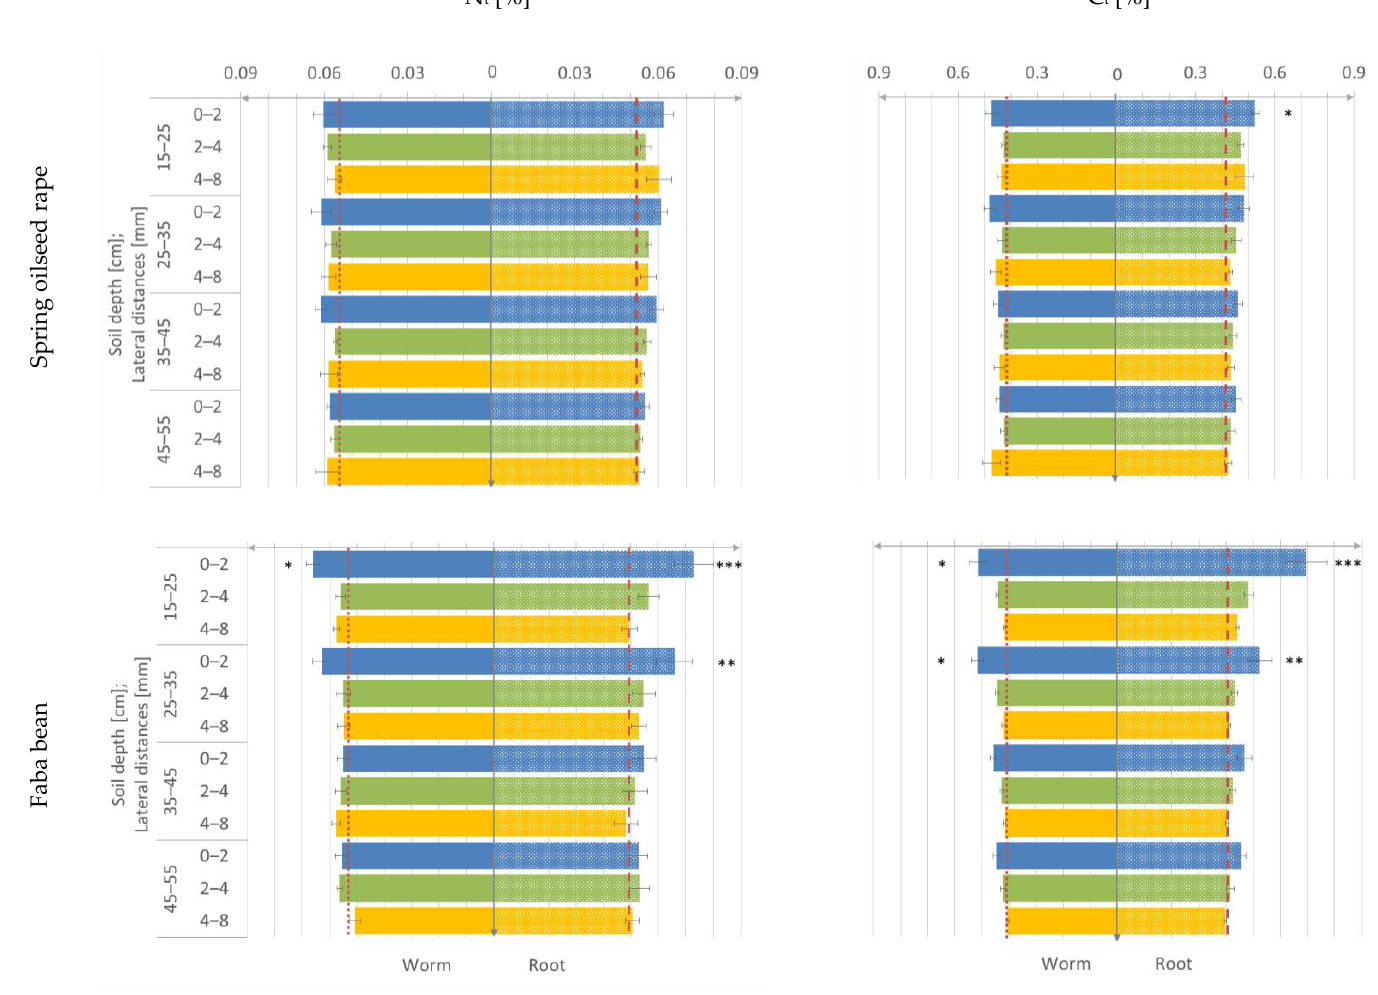
Figure 3. Lateral variation of N t - and C t -Content from biopore wall to bulk soil (red line) in worm and root biopores of spring oilseed rape and faba bean. Mean and SE of lateral distances at each depth intervals. Data of worm type at the left side and of root type at the right side of the graph. Means with an asterisk are significant higher than the bulk soil as the control (Dunnett-test, α = 0.05; p * < 0.05, ** < 0.01, *** < 0.001); Layers of the biopore sheath in blue = 0–2 mm, green = 2–4 mm and yellow = 4–8